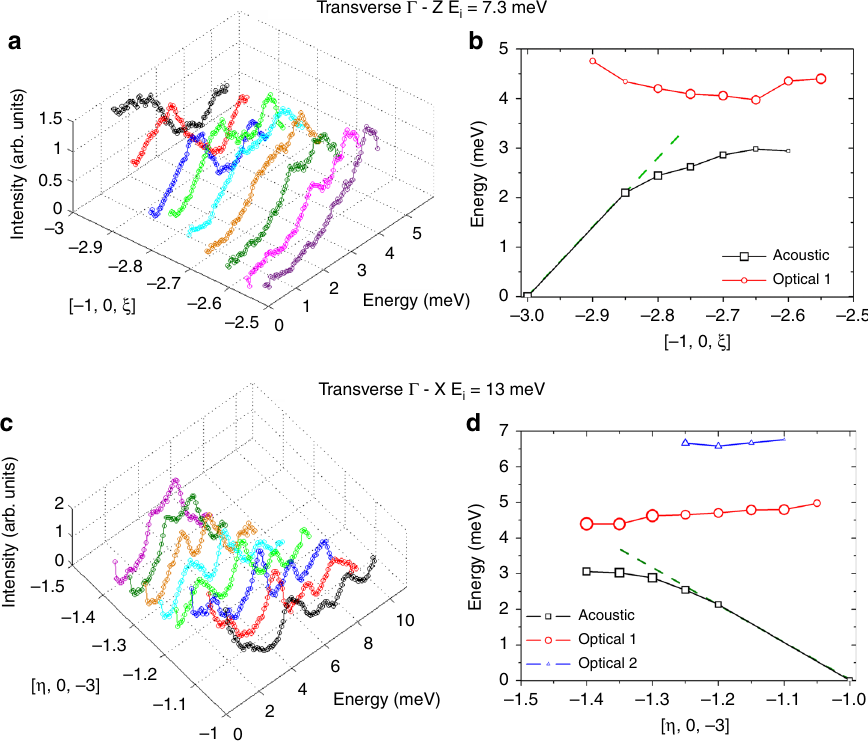
Fig. 5 Phonon anti-crossings. Panels a and c report 1D cuts as a function of energy of the LET data, obtained integrating around different values of Q for a Γ – Z around [ − 1, 0, − 3] with E i = 7.3 meV (Fig. 3b) and c Γ – X around [ − 1, 0, − 3] with E i = 13 meV (Fig. 4c). Panels b and d report the position of the peaks obtained from the 1D cuts of the data for both acoustic (black scatters) and optical modes (red and blue scatters). The intensity of each peak is translated into scatter dimension and the dashed green lines interpolate the linear behaviour of the acoustic modes. The data show the typical features of phonon ACs: bending of the acoustic mode, intensity exchange between acoustic and optical branches, with the latter drifting apart after the AC.